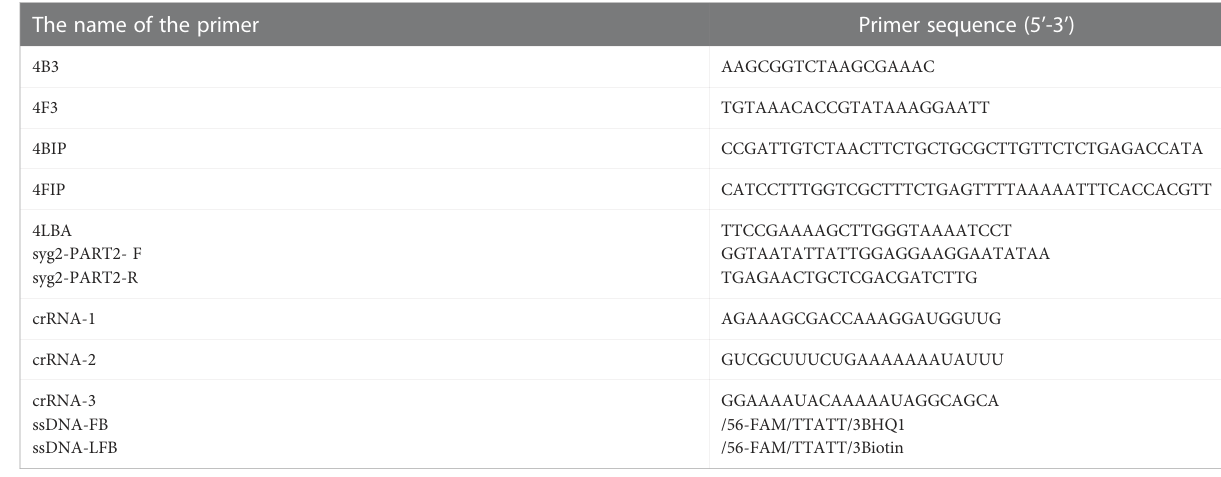
TABLE 1 Sequences of LAMP and PCR primers, crRNA, and report